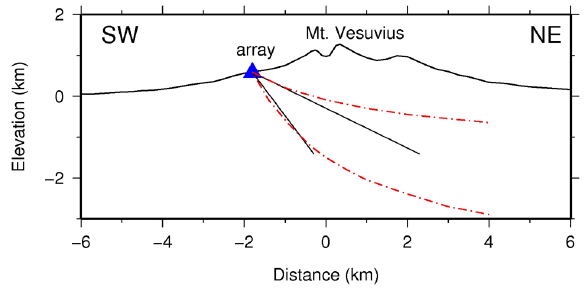
Figure 9. Cross-section of Mt. Vesuvius along the direction array- crater. The two straight black line, corresponding to incidence an- gles of 37 and 64 degrees, give a rough boundary of the volume sampled by the analyzed earthquakes. Considering an increase of the wave velocity with depth, more realistic limits are suggested by the red dashed